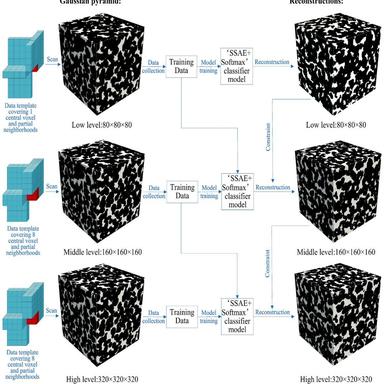
Schematic diagram of microstructure characterization and reconstruction using three-level approach.